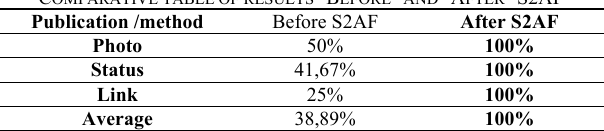
Comparative table of results : Table XI, represents a comparative table of the found results. As you see, our S2AF method participates in a reliable way to increase interaction toward publications in social networks. The goal without the use of S2AF will not be achieved, but by using S2AF system we can achieve a result 100%. TABLE XI C OMPARATIVE TABLE OF RESULTS "B EFORE " AND "A FTER " S2AF Publication